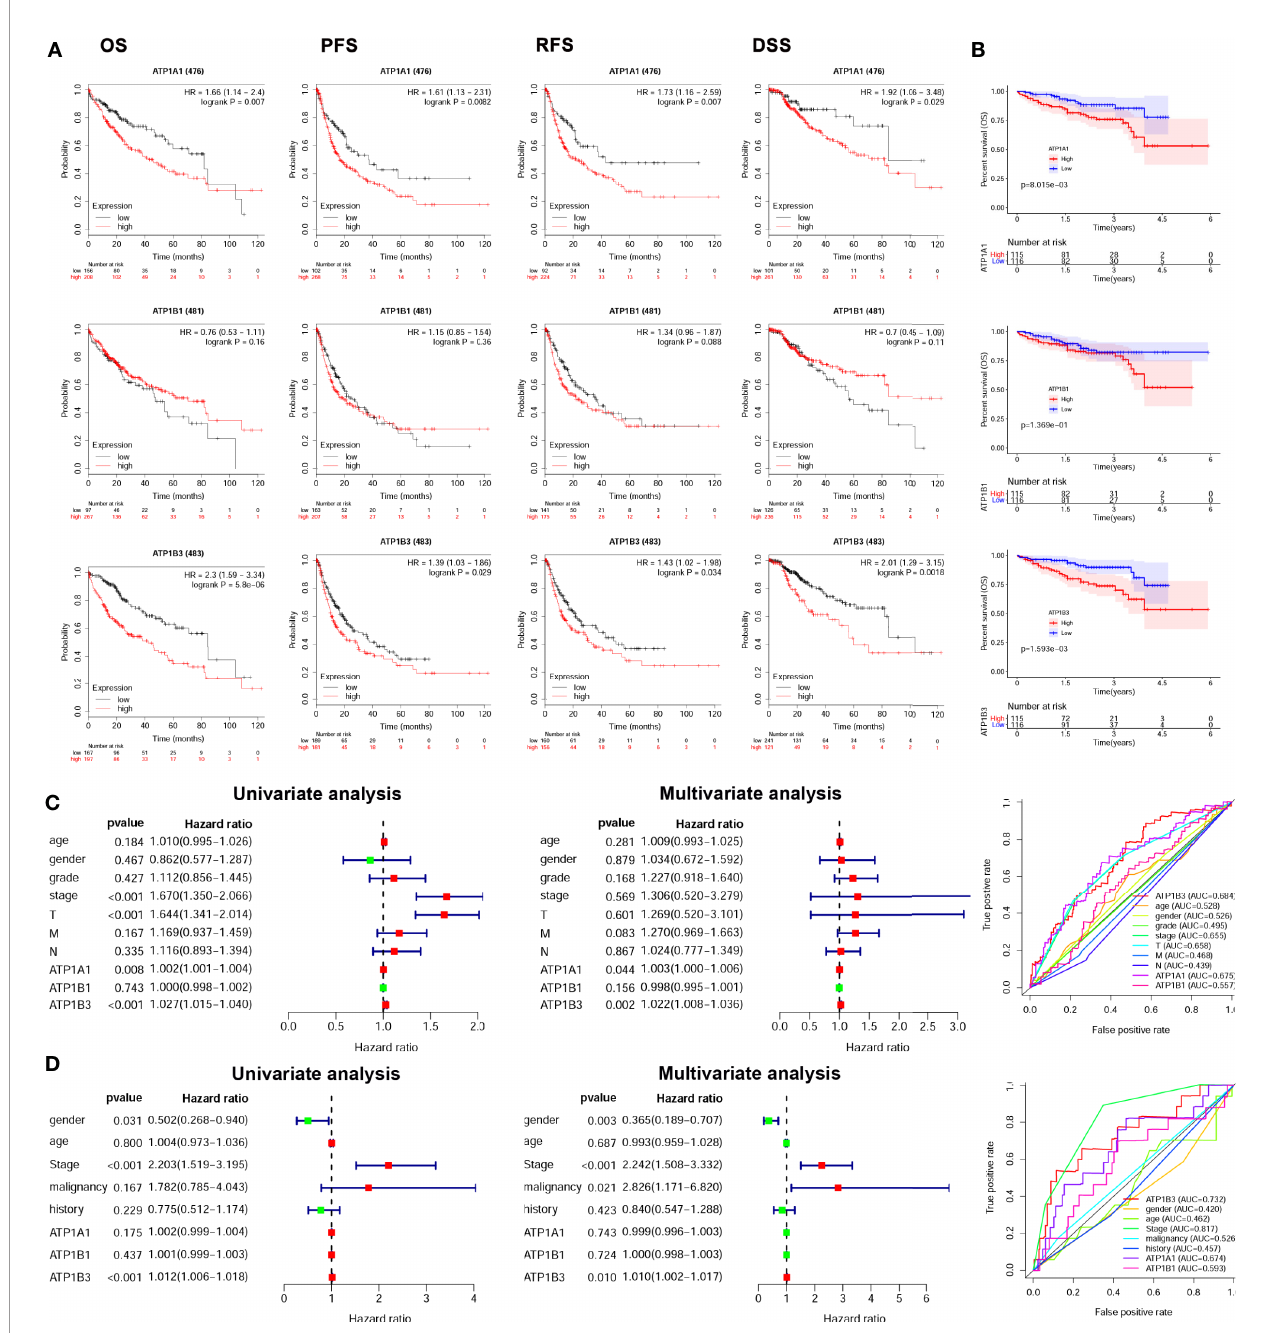
FIGURE 2 | ATP1A1, ATP1B1, and ATP1B3 mRNA are associated with prognosis of HCC patients. (A) The survival curves of OS, PFS, RFS, and DSS with high/ low ATP1A1, ATP1B1 and ATP1B3 in TCGA HCC cohorts using the Kaplan-Meier plotter (OS, n=364; RFS, n=316; PFS, n=370; DSS, n=362). The high and low mRNA expression is splitting by best cutoff. (B) The survival curves of OS with high/low ATP1A1, ATP1B1, and ATP1B3 in ICGC HCC cohorts, the high and low mRNA expression is splitting by median. Univariate and multivariate analysis and ROC curve revealed the relationship between ATP1A1, ATP1B1, ATP1B3, and the clinical factors with overall survival of HCC in (C) TCGA database and (D) ICGC database. (T, stage T; N, stage N; M, stage